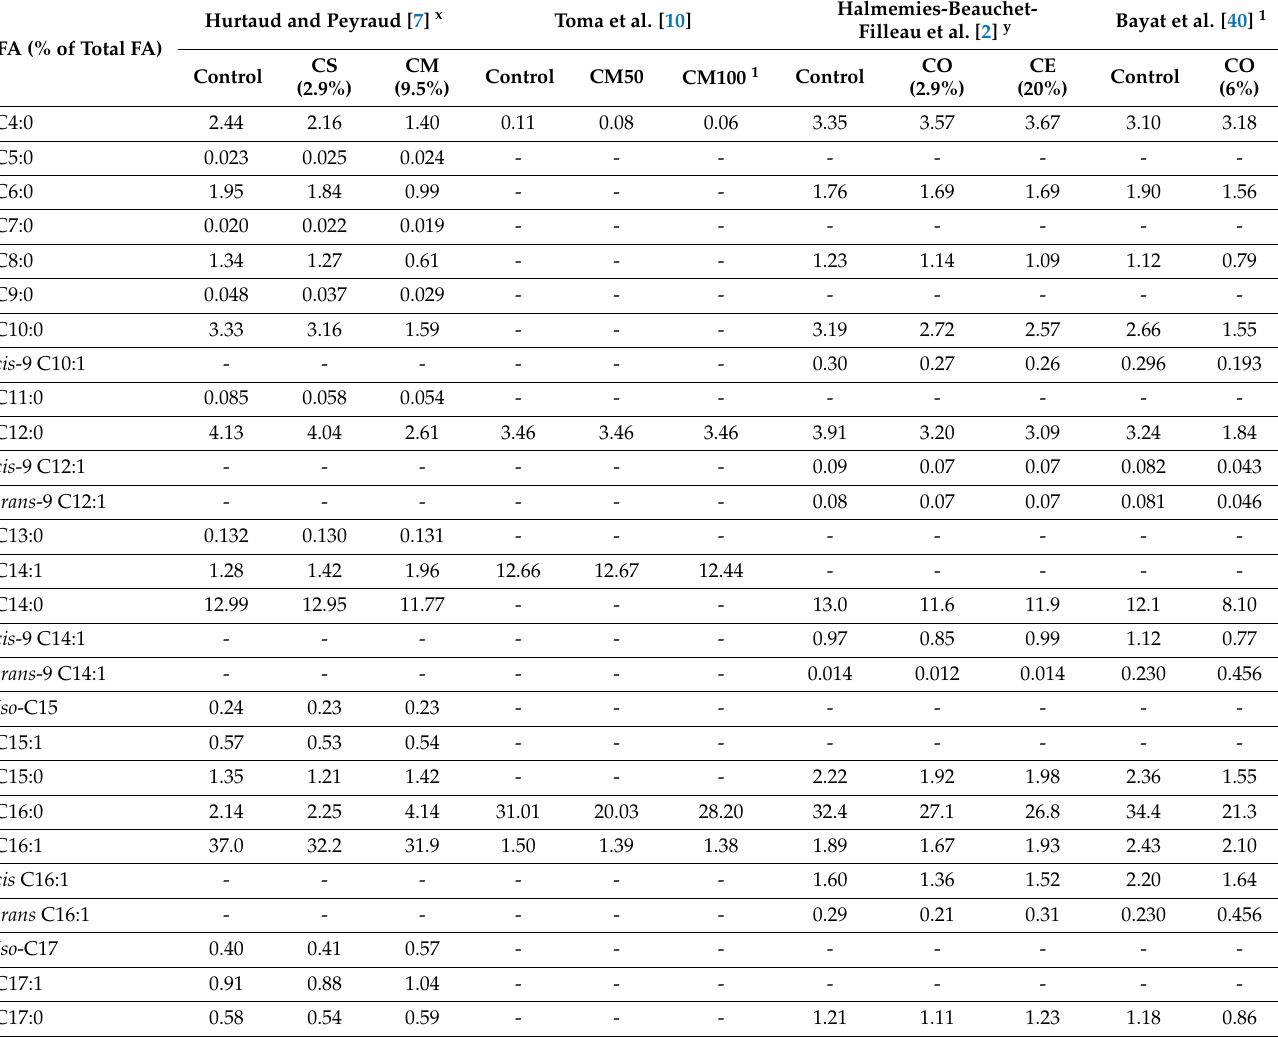
Table 10. Effect of camelina seed and its derivatives on the fatty acid composition of milk fat in dairy